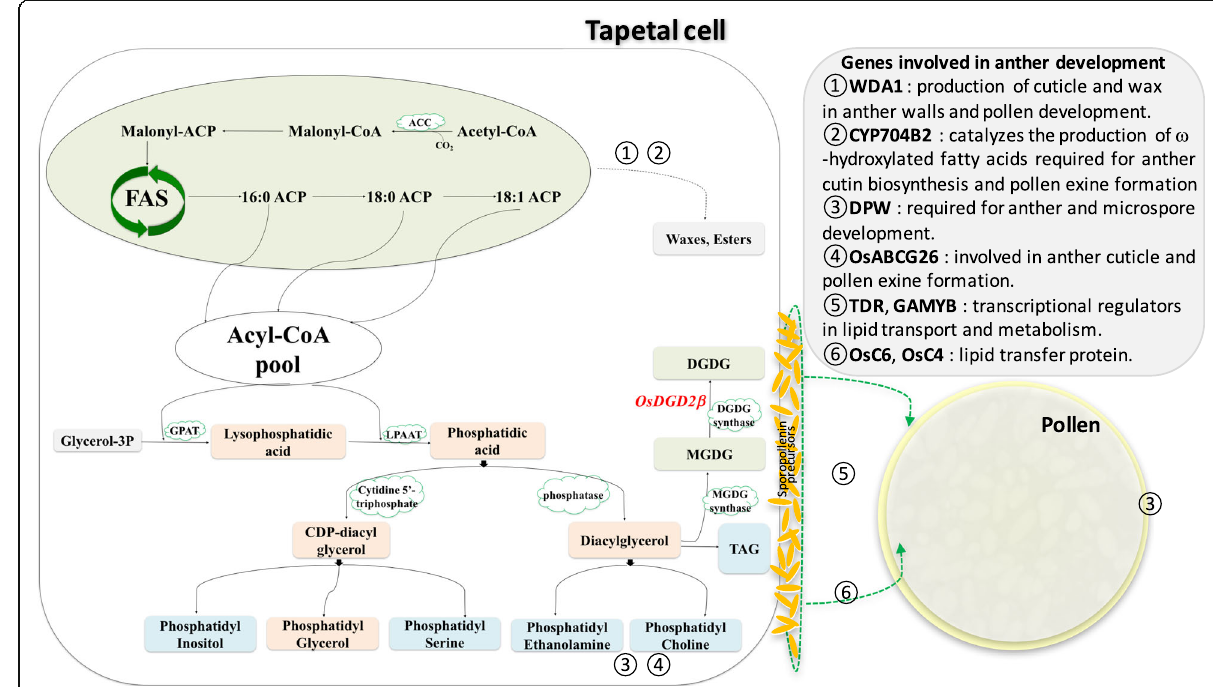
Fig. 1 Simplified diagram showing biosynthesis of lipids involved in anther development in rice. De-novo synthesis of fatty acid occurs in plastid (shaded green) while the pathways for synthesis of Phosphatidic acid, CDP-Diacylglycerol and Diacylglycerol are present in both plastid and endoplasmic reticulum (ER) (shaded orange). MGDG and DGDG are synthesized in the plastid; TAG and other Phospholipids (Phosphatidylcholine, Phosphatidylethanolamine, Phosphatidylserine, Phosphatidylinositol) are synthesized in ER (shaded blue); while Phosphatidylglycerol is synthesized in plastid as well as ER and mitochondria. The circled numbers represent the most active site of the corresponding protein localization or function. ACC, acetyl-CoA carboxylase; ACT acetyl-CoA transferase; ACP, Acyl carrier protein; LPAT, Lysophosphatidic acid transferase; MGDG, Monogalactosyldiacylglycerol; DGDG, Digalactosyldiacylglycerol; TAG,